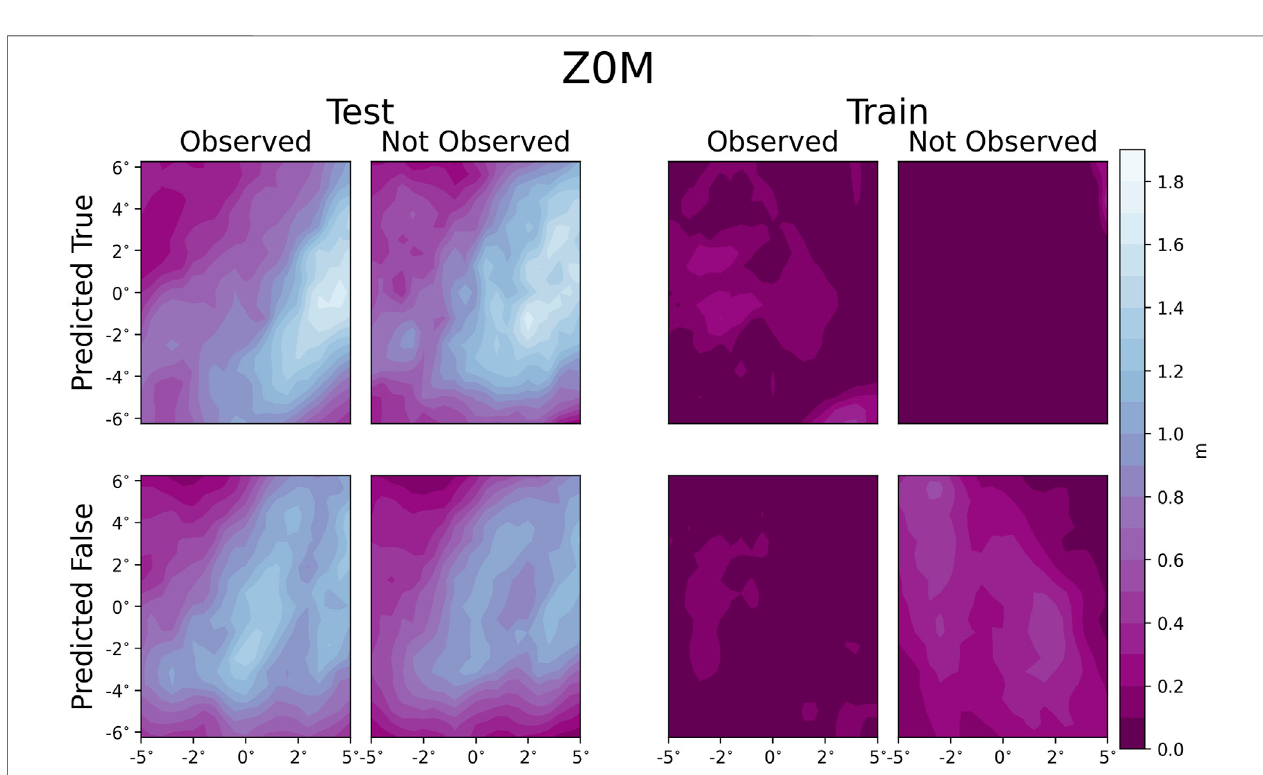
FIGURE 2 | Composite mean of the aerodynamic roughness length (Z0M).